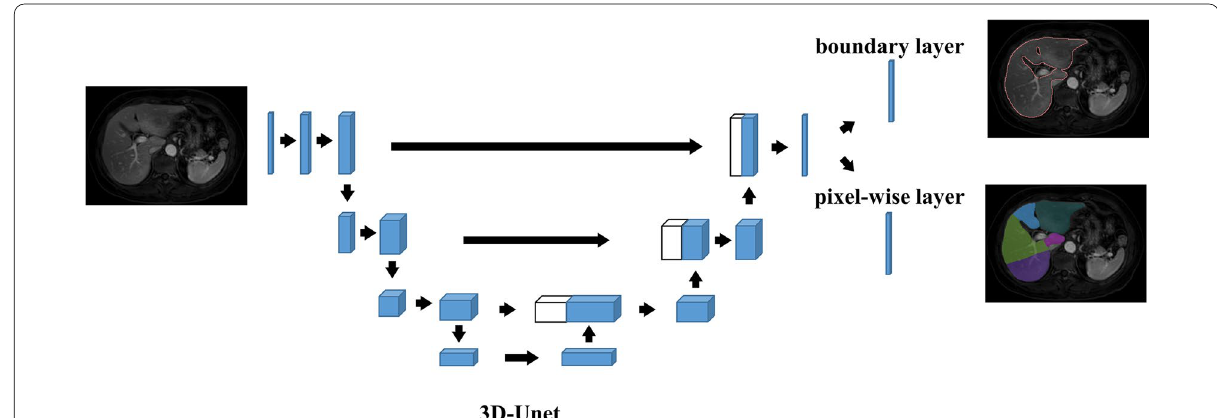
Fig. 2 Network structure of the liver segment segmentation